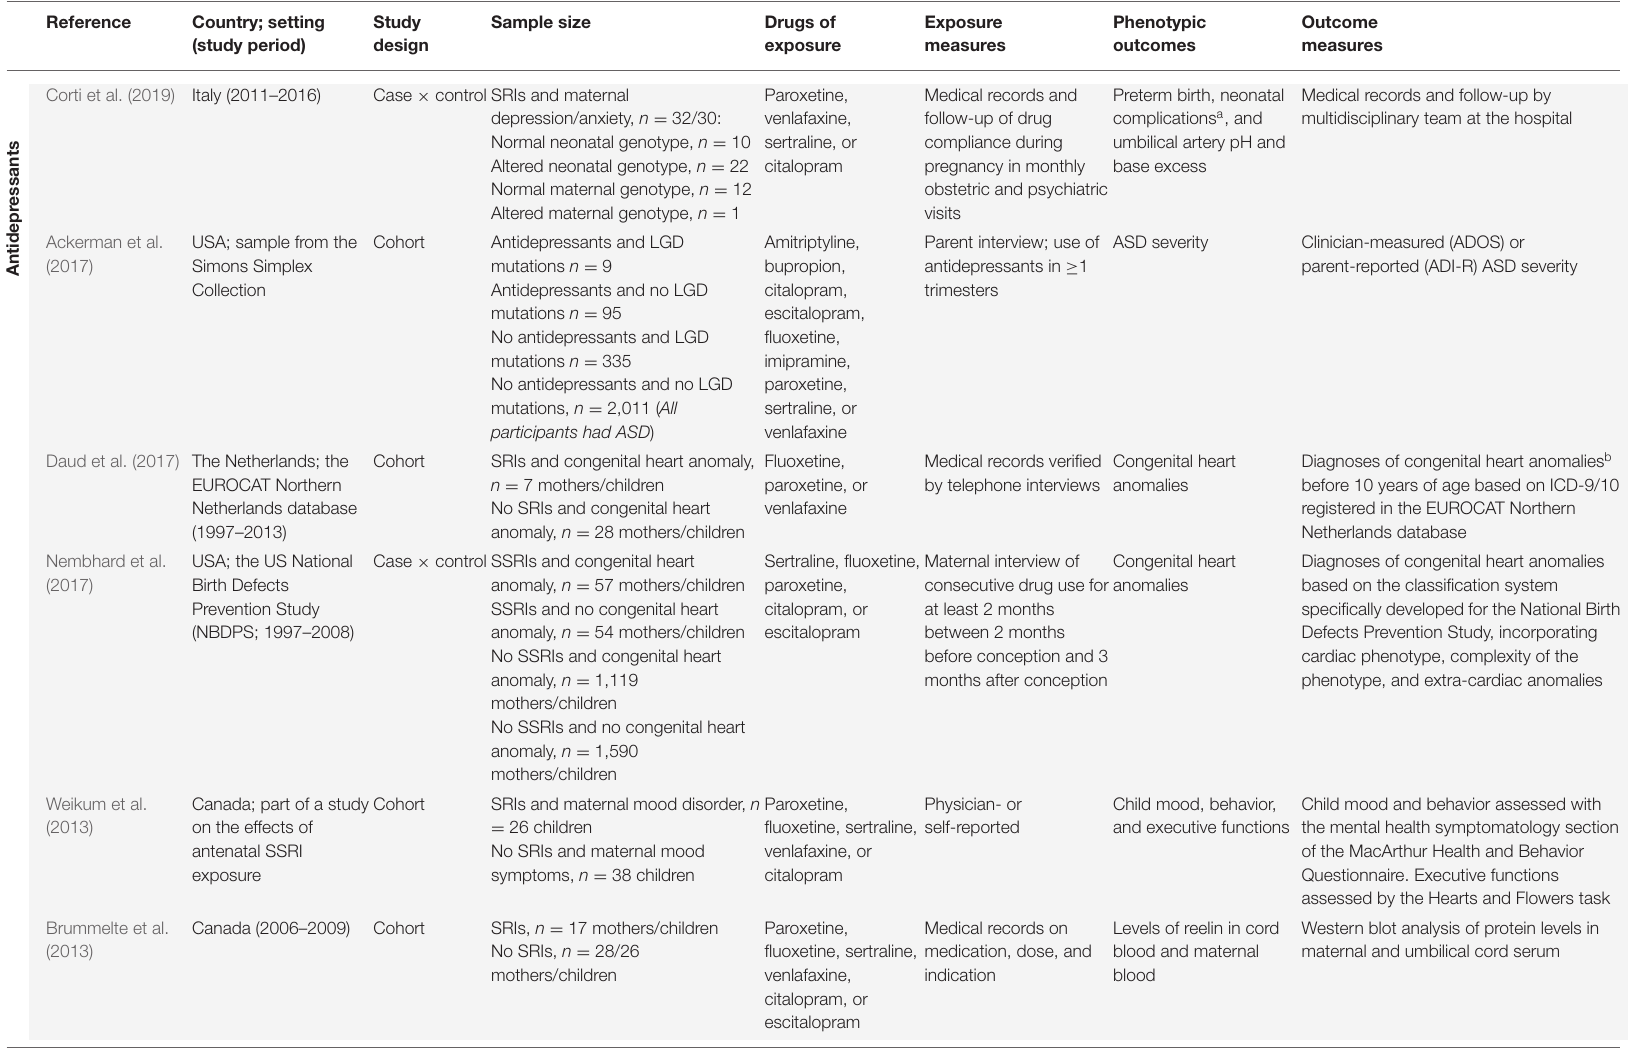
TABLE 1 | Overview of the reviewed